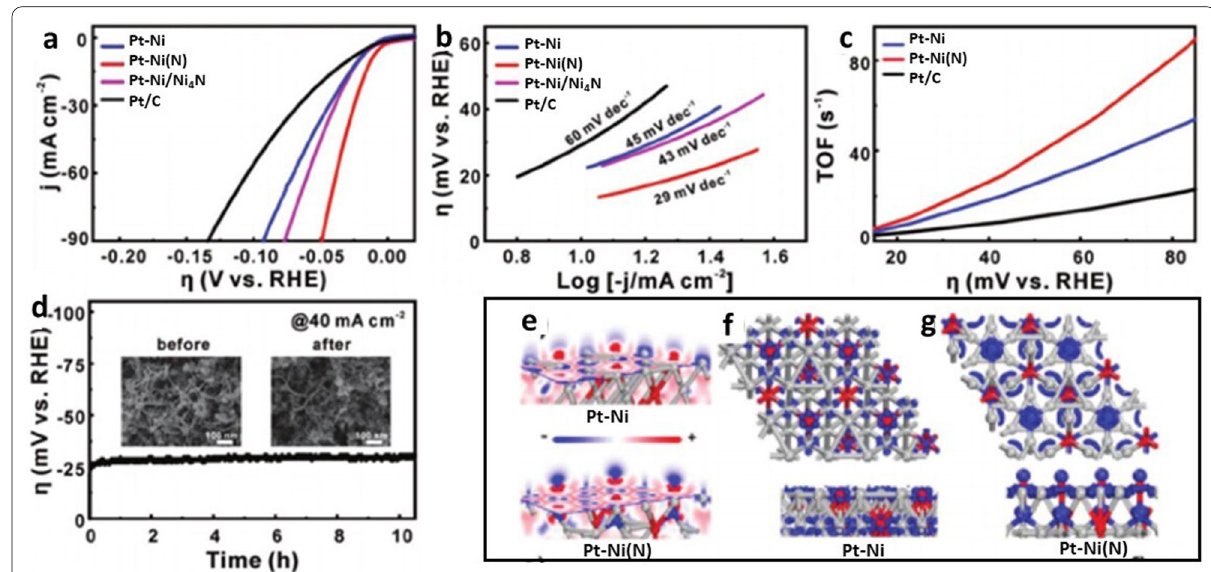
Fig. 5 a – d HER performance, a LSV curves comparing different catalysts in 1.0 M KOH with IR correction, b Tafel plots, c TOF curves, d Chronopotentiometric curve of Pt–Ni(N) NWs. Insets: SEM images of Pt–Ni(N) NWs before and after the stability test. e – g DFT calculation results: e electron density difference for slices of Pt–Ni and Pt–Ni(N), f , g top‑view and side‑view of orbitals above the Fermi level for Pt–Ni and Pt–Ni(N) (Figure reprinted with permission from Ref.